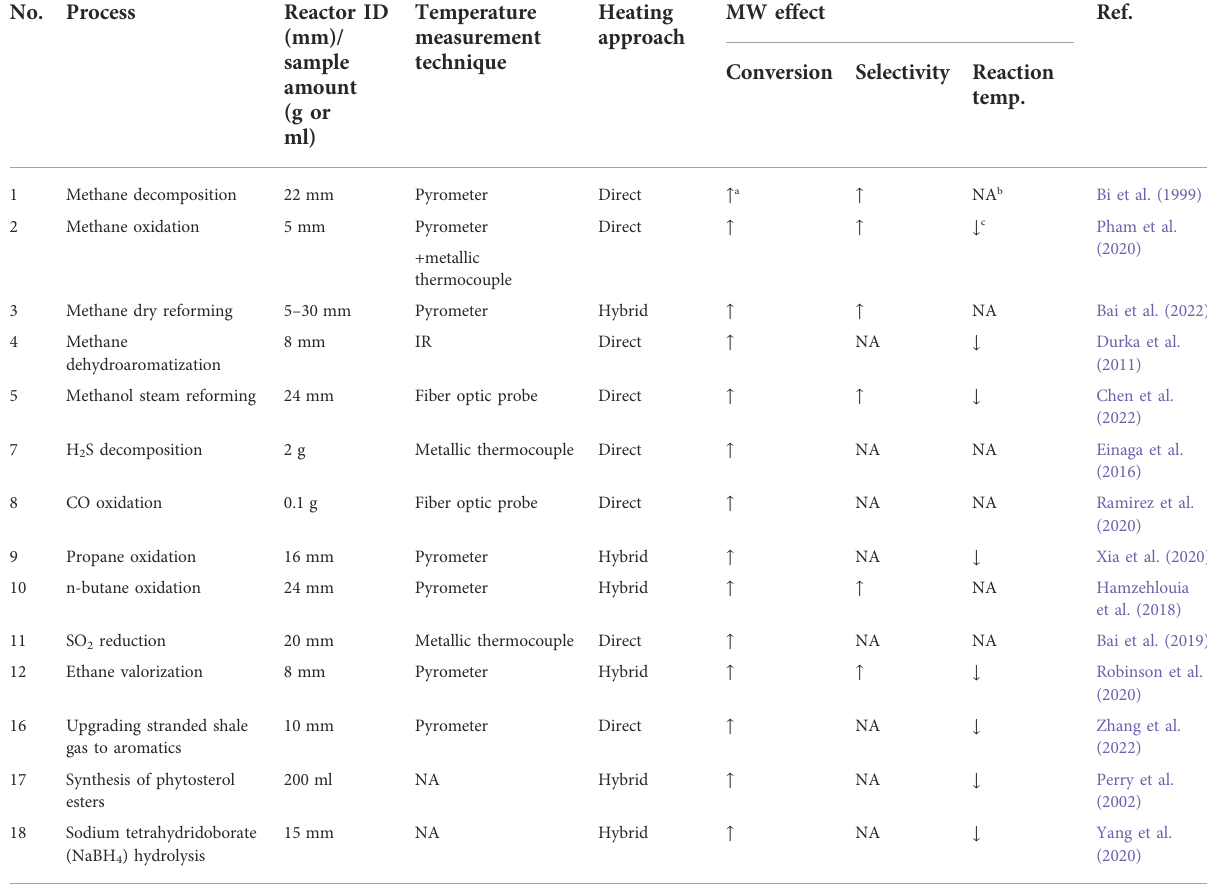
TABLE 1 Impact of MW heating on multiphase